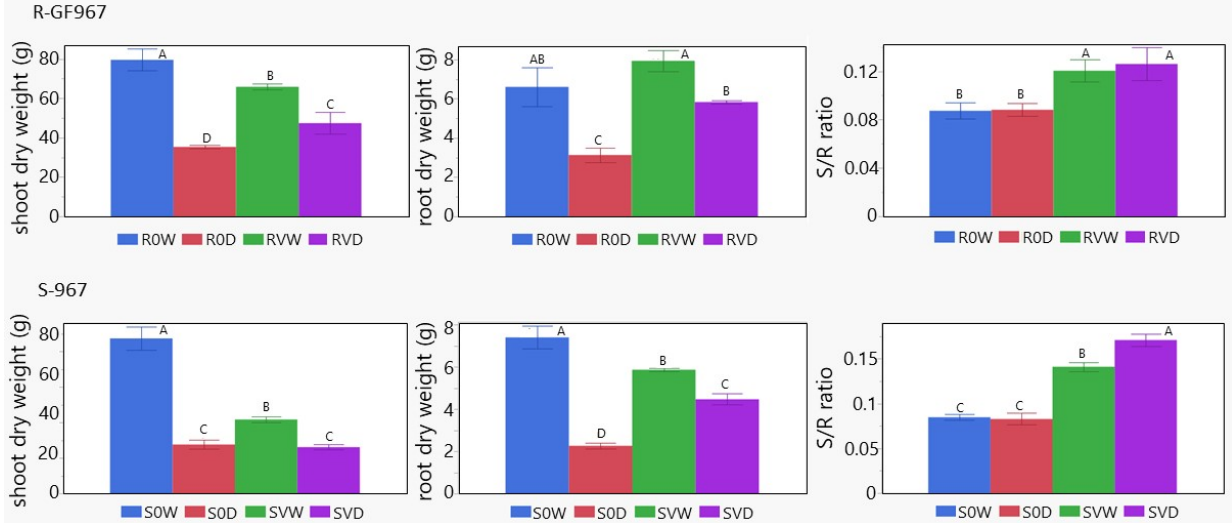
Figure 4. Biomass of TYLCV-infected tomatoes is less affected by drought than of uninfected. Dry weights in grams (g) of shoots and roots of R-GF967 and S-967 tomatoes, harvested at the end of experimental growth, was compared (R0W, R0D, RVW, RVD and S0W, S0D, SVW, SVD). Mean ± SE values with deferent letters are significant ( p = 0.05, Student’s t -test). Root to shoot ratio (R/S) measured for dry weights of tomatoes’ roots and shoots. Mean ± SE of R/S ratio; values with deferent letters are significant ( p < 0.05, Student’s t -test). Three independent biological repeats were used with similar